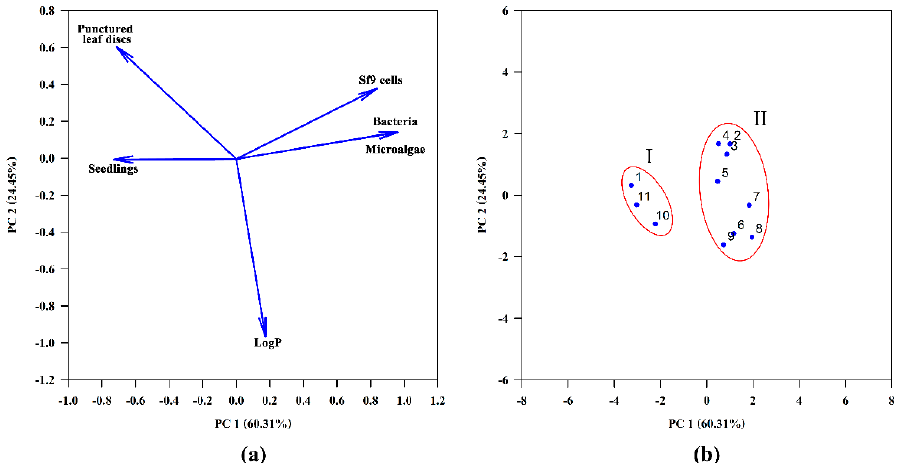
Figure 3. Principal component analysis (PCA) among biological activity and logP of the compounds 1 – 11 : ( a ) loading plot, ( b ) score plot. The red circles indicate the separated groups (subsets) of the studied compounds.